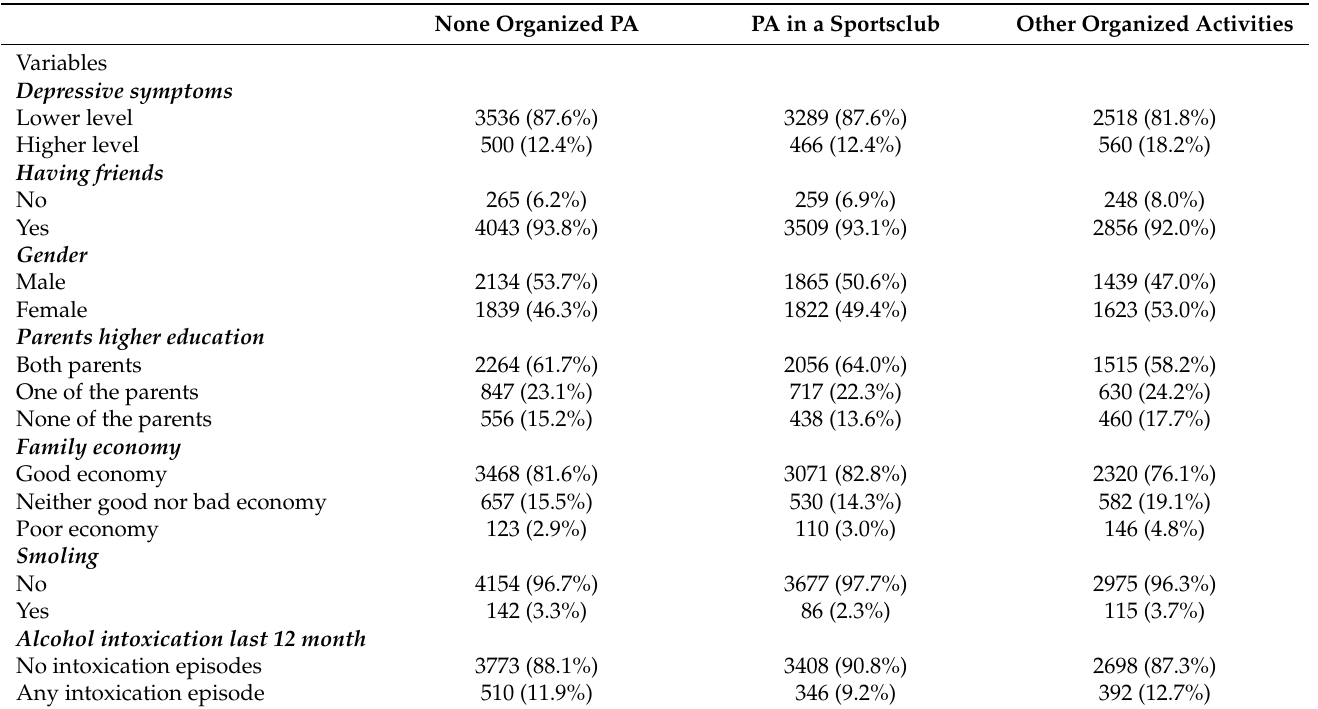
Table 3. Youth data surveys: baseline characterstic of leisure time activities taking place in different contexts in adolescents aged 13–16 years in